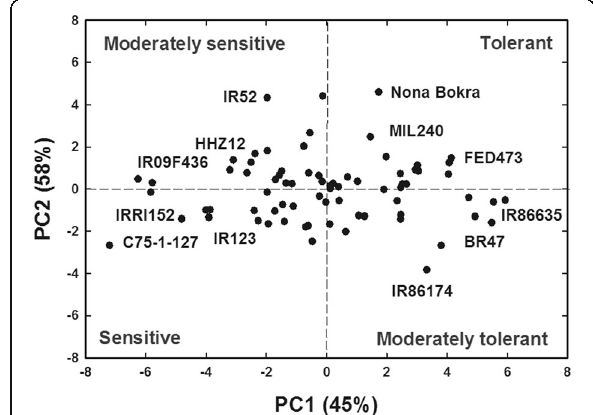
Fig. 8 Principal component analysis (PCA) for the first two principal components (PC) scores, PCA1 vs. PCA2 describing the classification of rice genotypes into different salt tolerant groups (salt sensitive, low, moderate, and high salt tolerant) based on all the morpho- physiological parameters measured 37 days after sowing for all the genotypes. Rice genotypes with high/low scores in each tolerant category are identified in the PCA